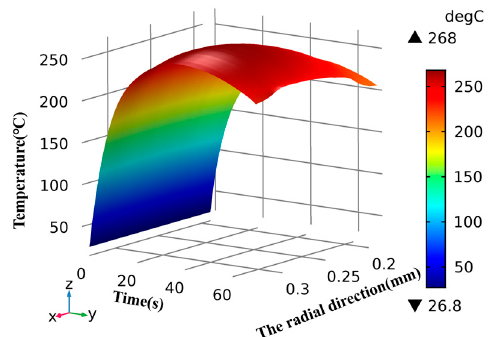
Figure 9. Three-dimensional cloud of time-temperature along the radial direction of a ventilated brake disc.